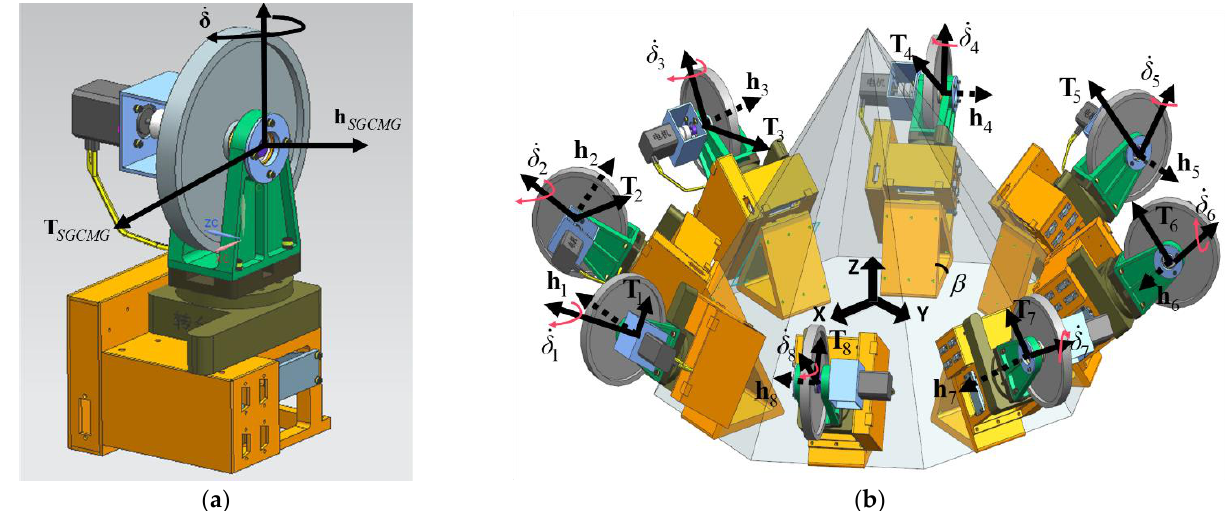
Figure 2. Composition schematic of SGCMG and 8−SGCMGs. ( a ) SGCMG, ( b ) 8−SGCMGs. The gimbal axis of SGCMG is always perpendicular to the flywheel axis, and when the gimbal axis rotates, the direction of momentum changes and the output torque of the entire SGCMG system can be obtained from the coupling calculation between the momentum and the velocity of the gimbal axis. The gimbal angular velocity of SGCMGs is defined as . δ , and the momentum generated by flywheel is defined as h SGCMG . The output torque of the SGCMG is given